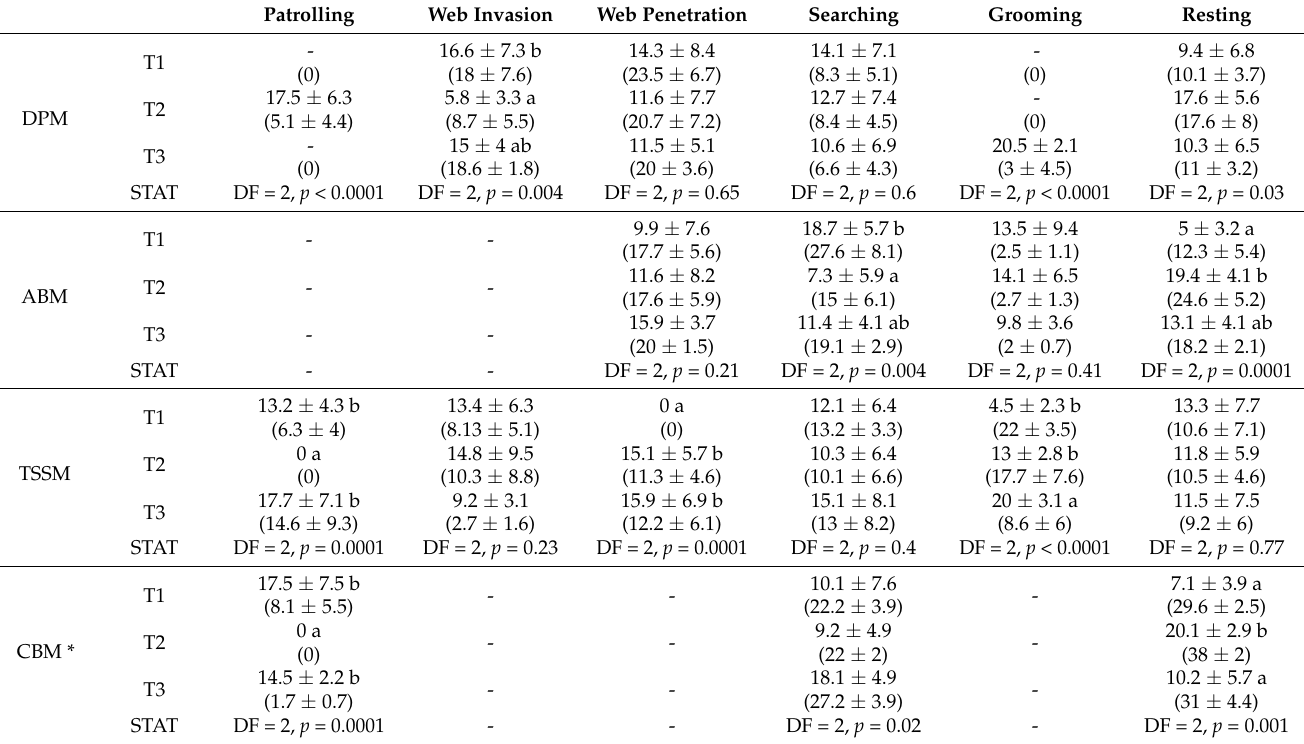
Table 1. Comparison among treatments for the time spent (mean ± std.dev) by the predator S . gilvifrons in six behavioral categories against four spider mite pest species (parentheses represent mean ± std.dev of untransformed time measurements).